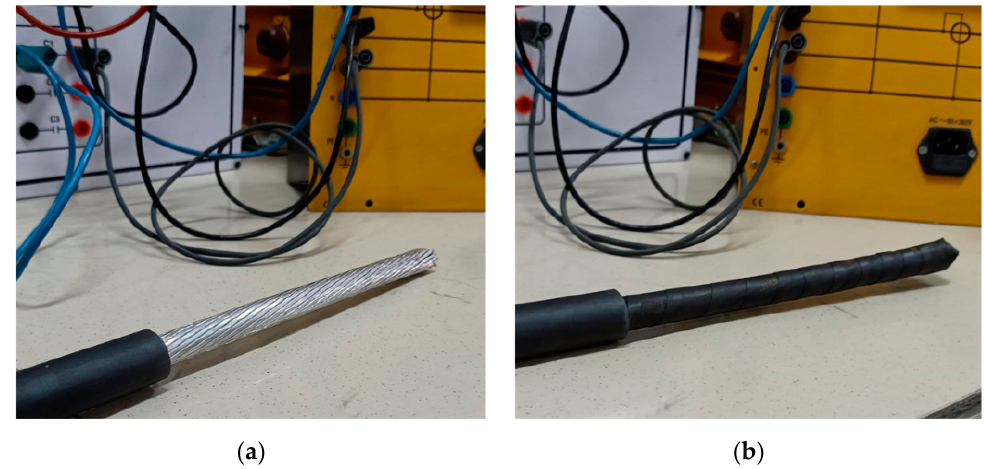
Figure 16. ( a ) Simple stranded conductor and ( b ) semiconducting film (SCF)-coated stranded conductor used in the development of FGIL models.